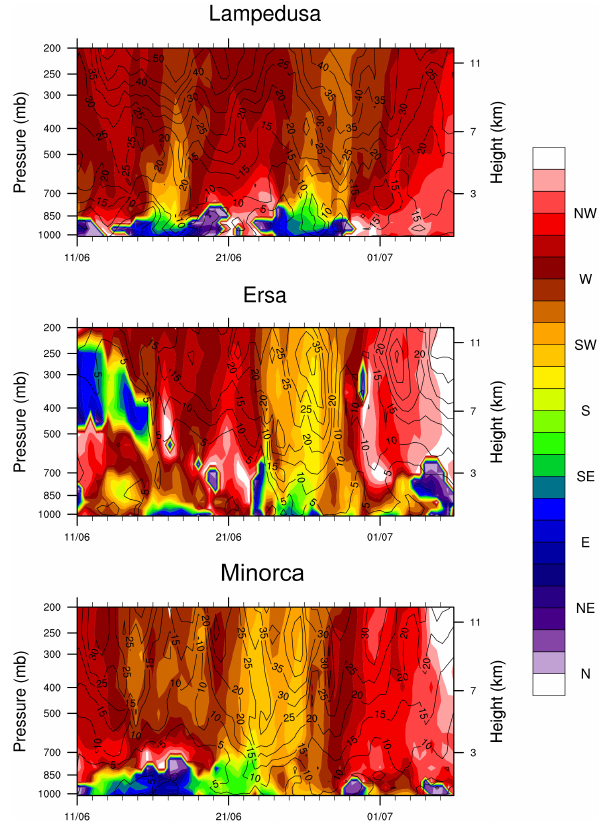
Figure 8. Wind profiles between 1000 and 200hPa during the SOP- 1a experiment for three different sites (Ersa, Lampedusa and Mi- norca) simulated from the ALADIN-Dust model. The wind inten- sity (in ms − 1 ) is also reported at the different